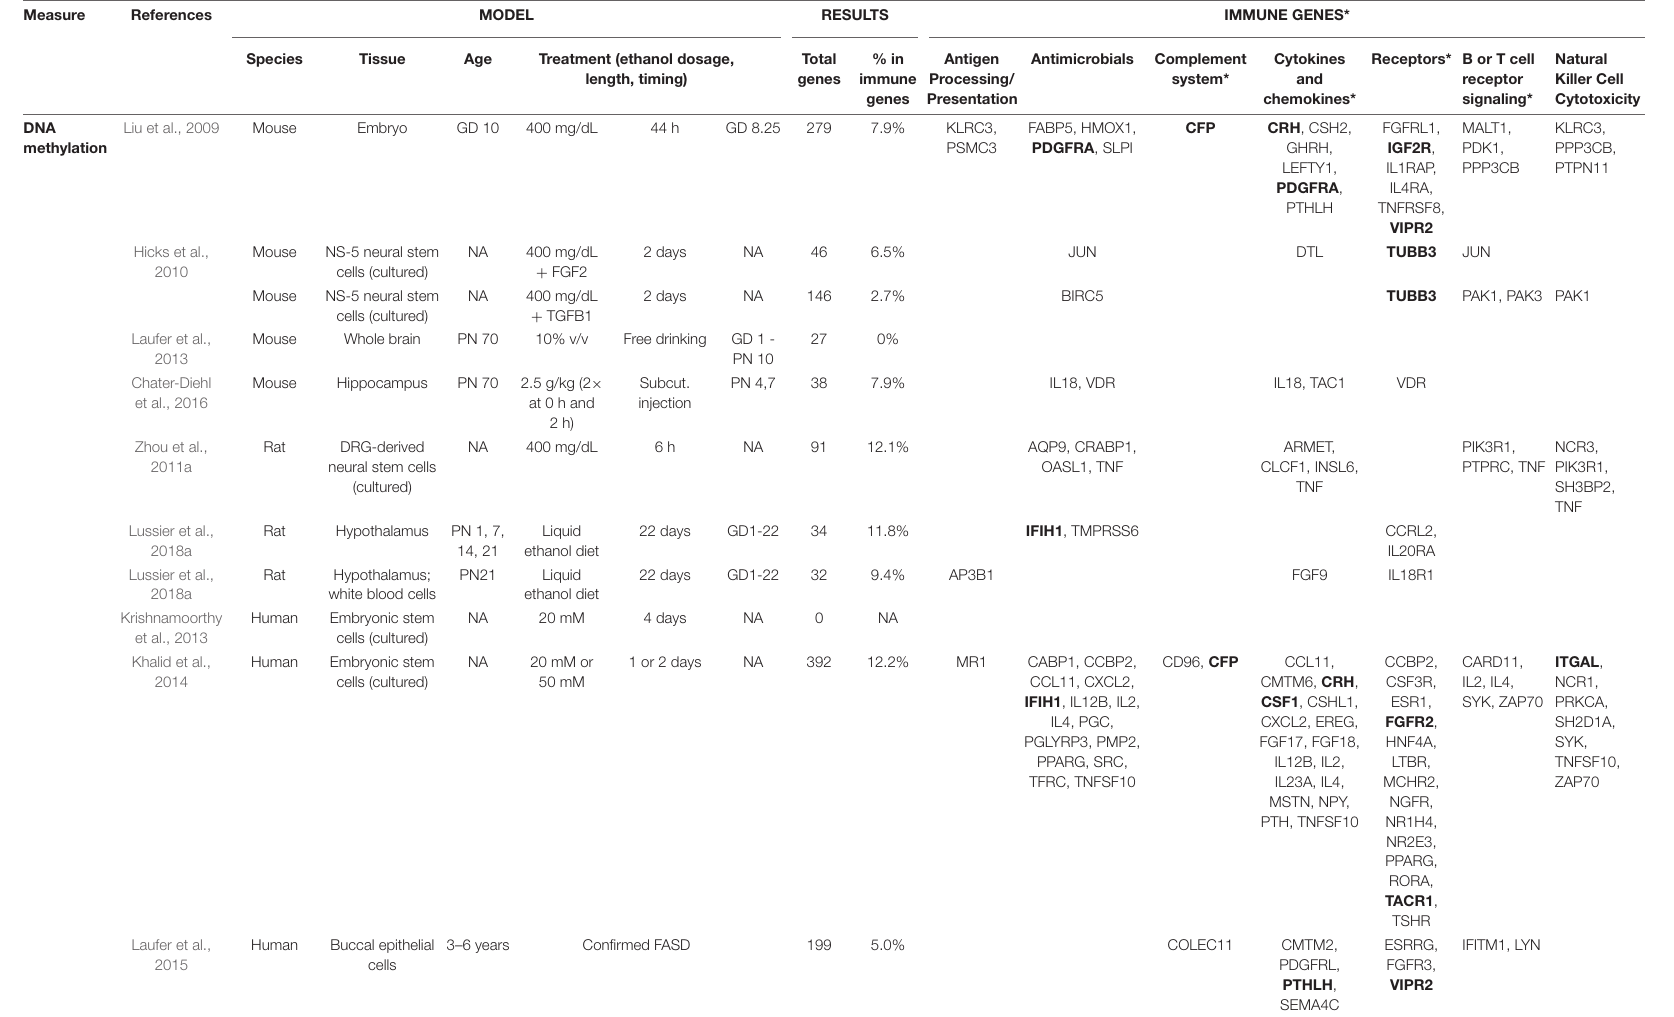
TABLE 2 | Differential effects of PAE on the epigenetic profiles of immune genes. Measure